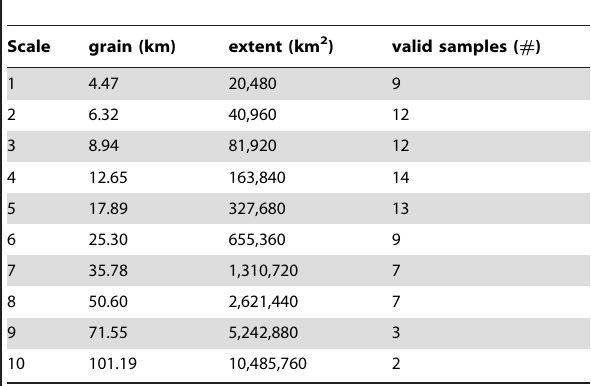
Table 2. A list of sampling units used in the analyses, including grain size (side length in km) and extent (area in km 2